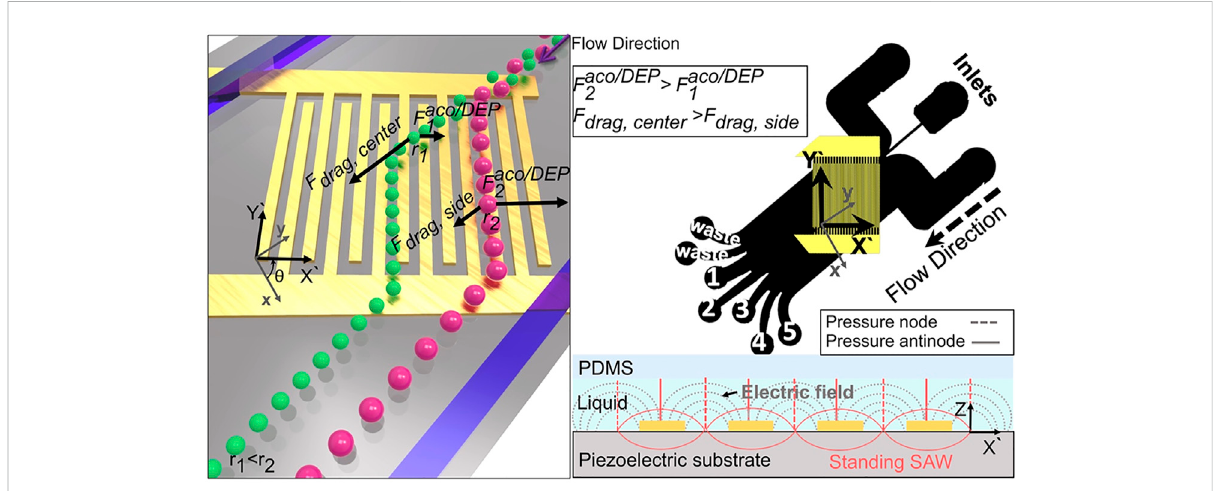
FIGURE 5 Schematicillustratestheworkingmechanismofthesystem.Leftimageshowsthatparticlesofdifferentsizesaresubjectedtodifferentforcesin the acoustic and electric fi elds, causing the separation of particles of different sizes. The right one is the schematic diagram of PDMS microchannel device and the side view of electric and acoustic fi eld around the electrodes (Tayebi et al.,